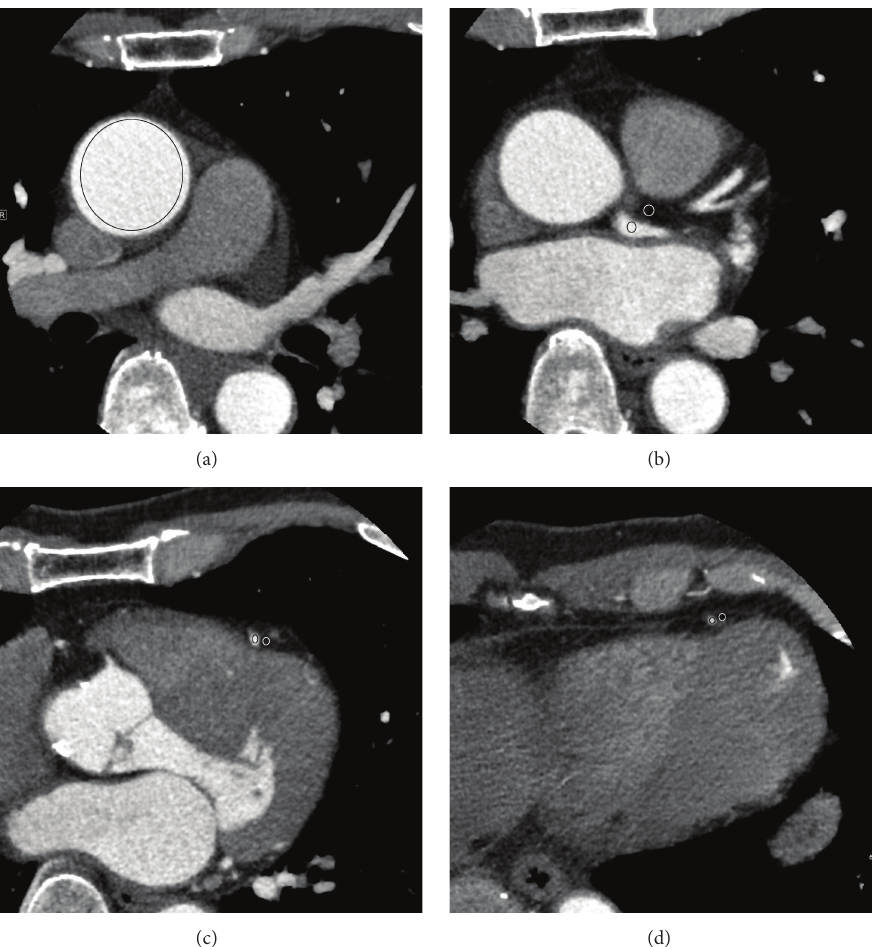
Figure 1: Examples of regions of interest (ROIs) drawn on a cross-sectional image, at the proximal ascending aorta; the proximal, middle, and distal segments of the left anterior descending artery. Black circle shows ROIs drawn inside the lumens of the arteries, while white circle shows ROIs drawn in the nearby connective tissue to calculate contrast-to-noise